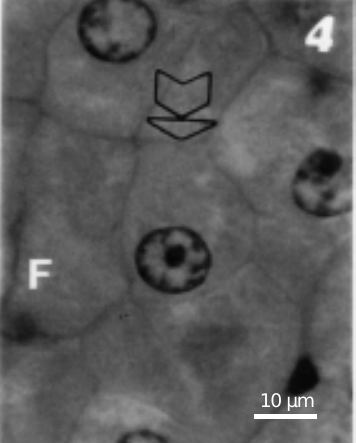
Figure 4 - Fasciculata region (F) of a viscacha captured in August (winter). The cytoplasm shows a pronounced decrease in the con- tent of lipid droplets (arrow) compared to that observed in March. H-E; 1000X.